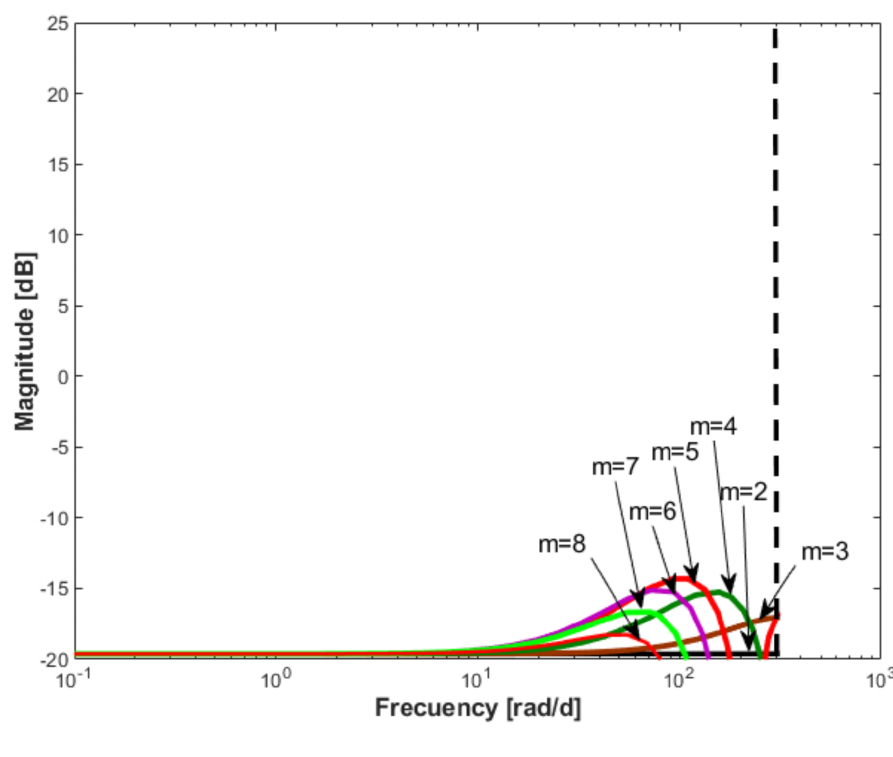
Figure 7. The Bode characteristics of the Q ( z, θ ) for (cid:101) ω = 1.5 [ rad/d ] and m = 2, . . . ,8.